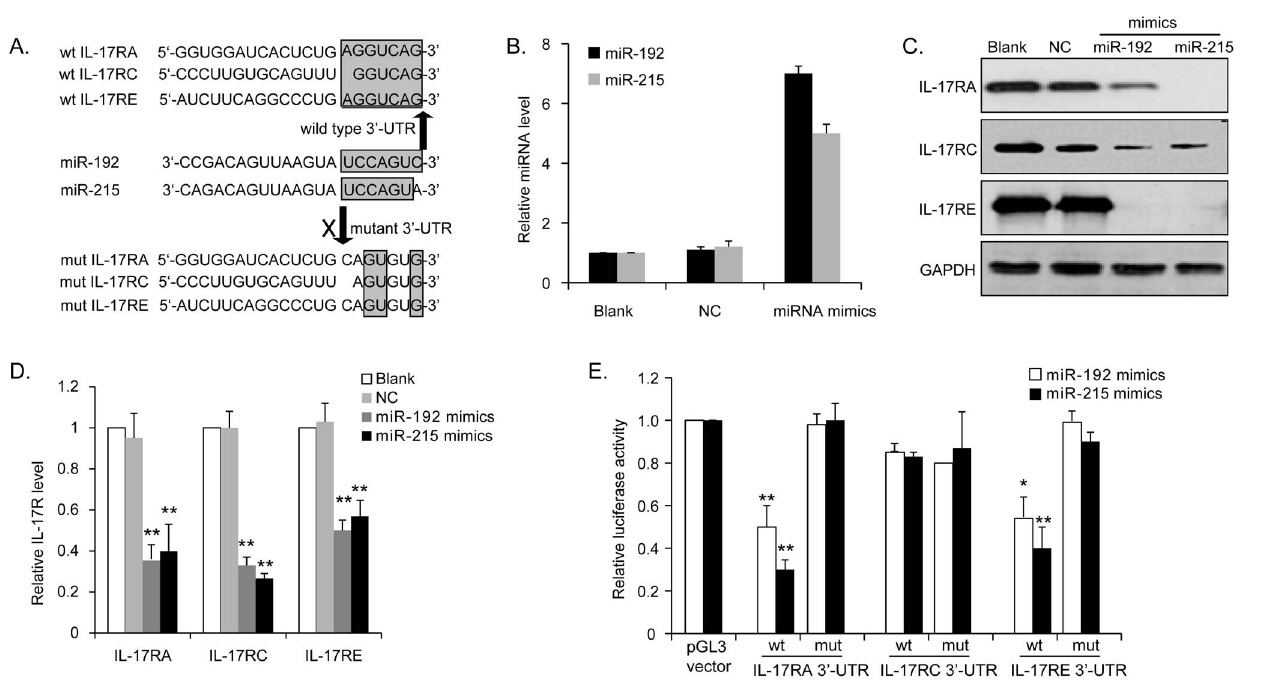
Fig. 5. miR-192 directly targets IL-17Rs, including IL-17RA and IL-17RE. (A) The predicted miR-192 and miR-215 binding sites within 3 9 -UTRs of IL- 17RA, IL-17RC and IL-17RE, and their mutated versions by site mutagenesis. Upregulation of miR-192 and miR-215 (B) repressed expressions of IL-17RA, IL-17RC and IL-17RE at both protein (C) and mRNA (D) level. (D)The repression of luciferase activities by 3 9 -UTRs of IL-17RA and IL-17RE, but not IL- 17RC, was dependent on miR-192 and miR-215. Mutated 3 9 -UTRs of IL-17RA and IL-17RE abrogated miR mediated repression of luciferase activity. (**P , 0.01, Figure is representative of 3 experiments with similar